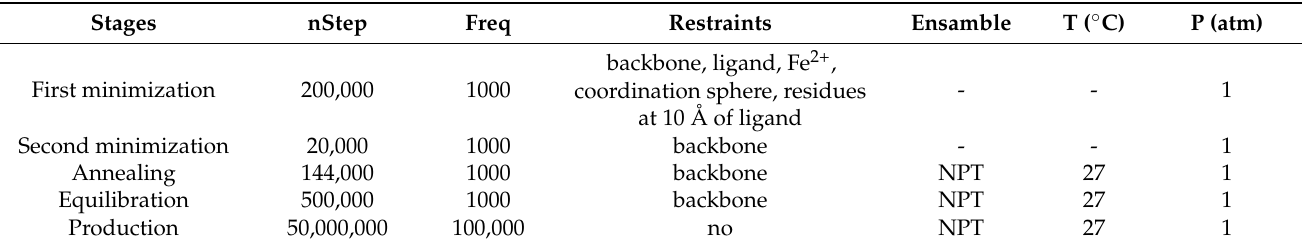
Table 8. Stages of 100 ns molecular dynamics simulation. Prior to production, the system was pre- pared, with four stages in which restraints were maintained. nStep = sampling points corresponding to 2 fs. Freq = every how many fs values are